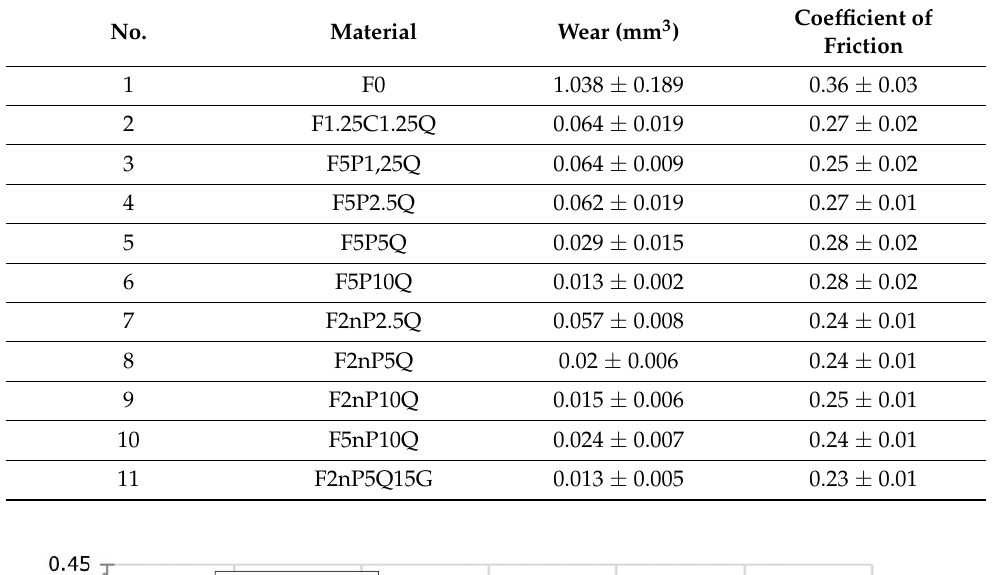
Table 4. The results of wear and friction coefficient of the unfilled FEP and FEP-based composites after 30 min of dry sliding.